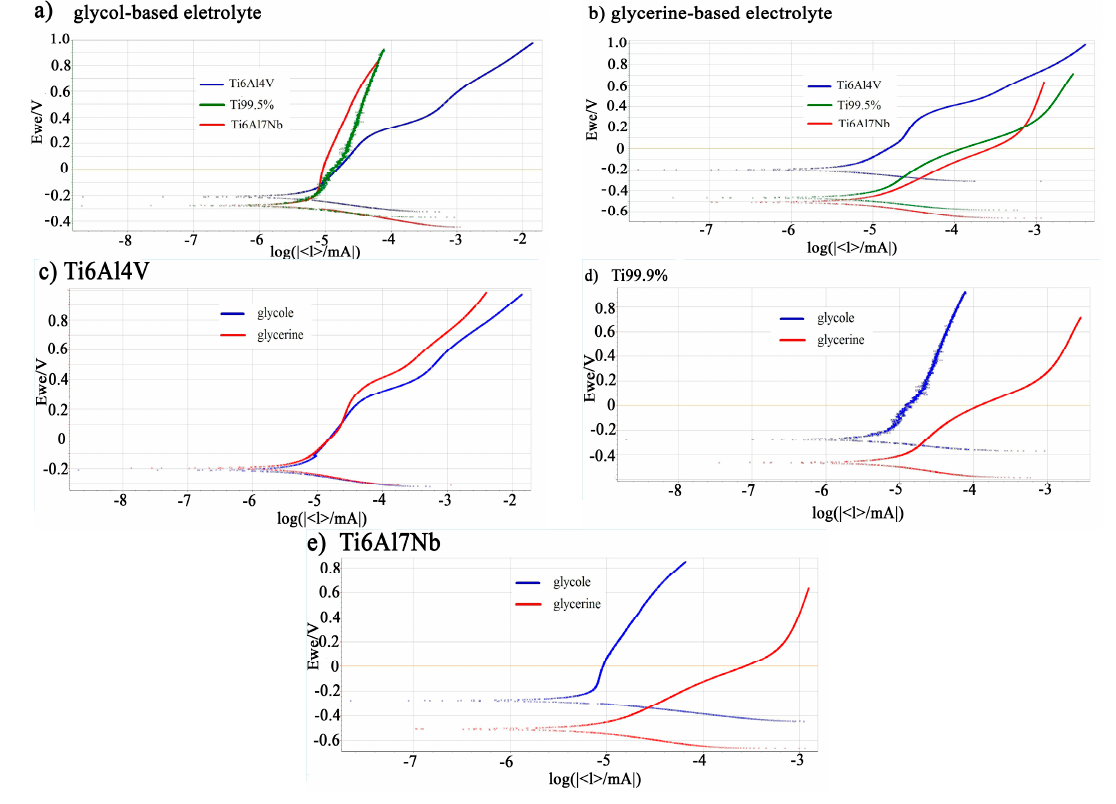
Figure 3. Polarization curves measured in glycol-based ( a ) and glycerine-based ( b ) electrolyte. The polarization curves for individual alloy composition: Ti6Al4V ( c ), Ti 99.5% ( d ), and Ti6Al7Nb ( e ).